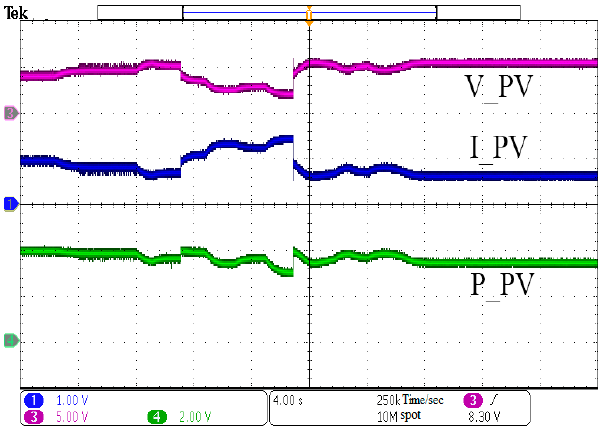
Figure 19. The first PV array’s current, voltage, and power under load and radiation changes.